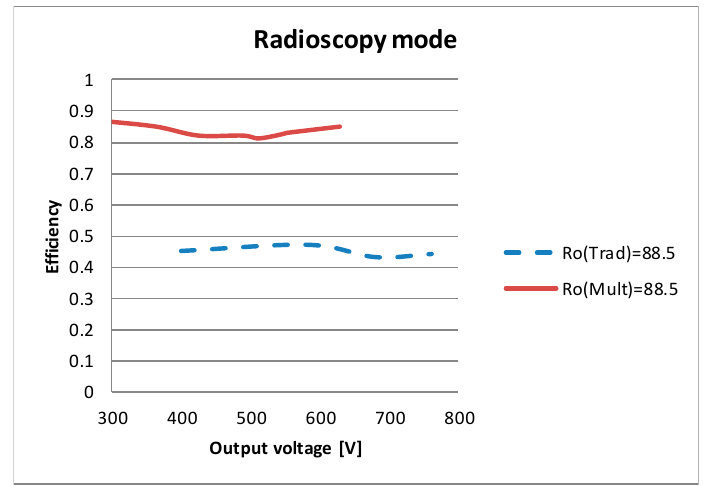
Figure 18. Efficiency during fluoroscopy operation for different loads and output voltage (referred to the primary side) by using the traditional LCC (Trad) or the multilevel LCC (Multi).